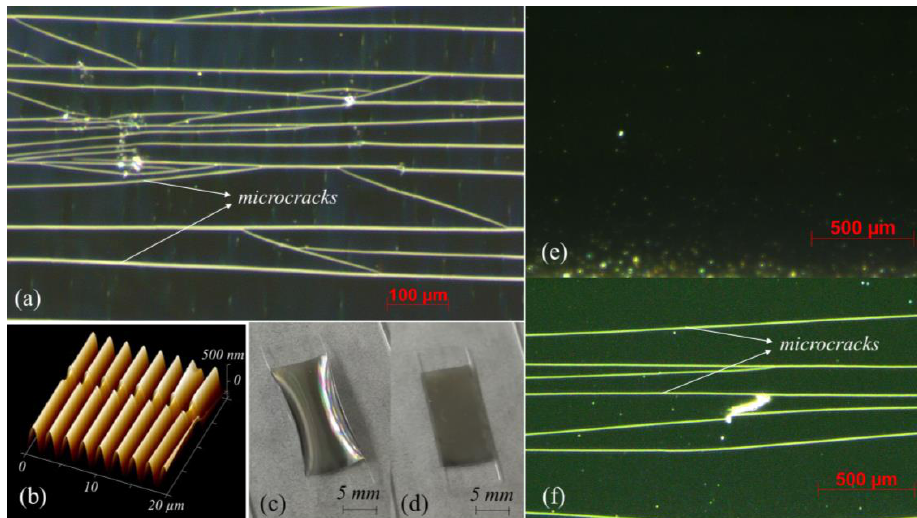
Figure 2. ( a ) Optical image of microcracks in 30% prestrain CoFeB film. ( b ) AFM image of a microcrack in 30% prestrain CoFeB film. ( c ) Pt film with 10% prestrain, the film is curved. ( d ) Film in Figure 2c after being flattened. ( e ) Optical image of Pt film with 10% prestrain, no microcrack. ( f ) Optical image of flatten film in Figure 2d, many microcracks appear.